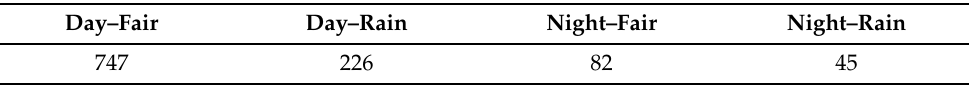
Table 1. Number of 20-s-long driving sequences belonging to the four main categories considered in this work (10 Hz sample